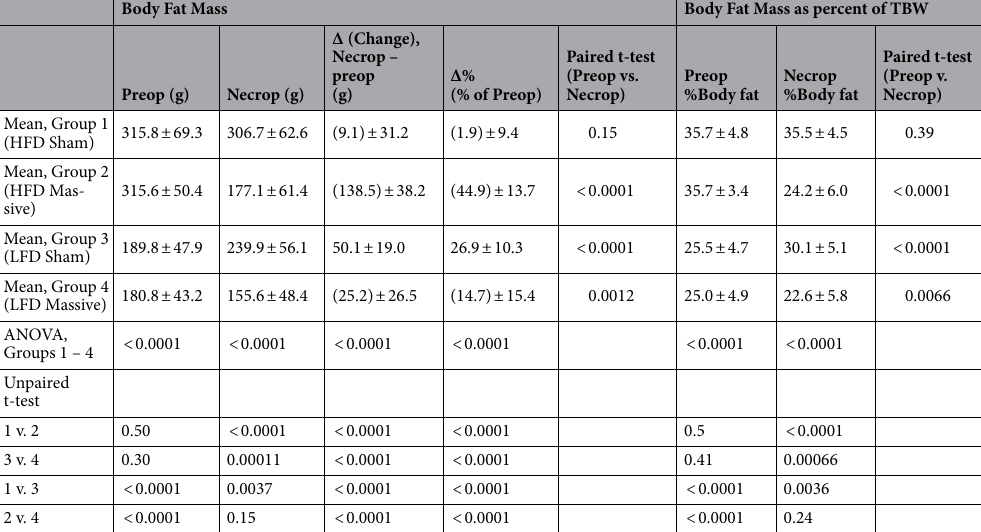
Body Fat Mass Body Fat Mass as percent of TBW